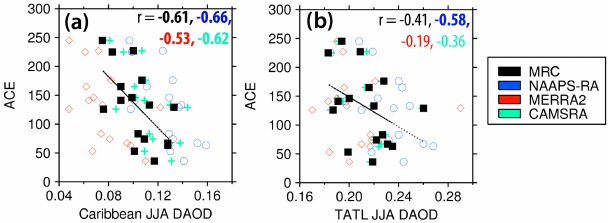
Figure 5. Scatterplot showing the relationship between annual At- lantic accumulated cyclone energy (ACE) and JJA region-averaged DAOD from MRC, NAAPS-RA, MERRA-2, and CAMSRA over the (a) Caribbean and (b) the tropical North Atlantic. One unit of ACE equals 10 4 kt 2 . Correlations ( r ) between ACE and DAOD are color-coded for different DAOD products and overlaid on each plot, and statistically significant correlations are in bold. The possible causes of the DAOD difference between the reanalysis products are discussed in Sect.